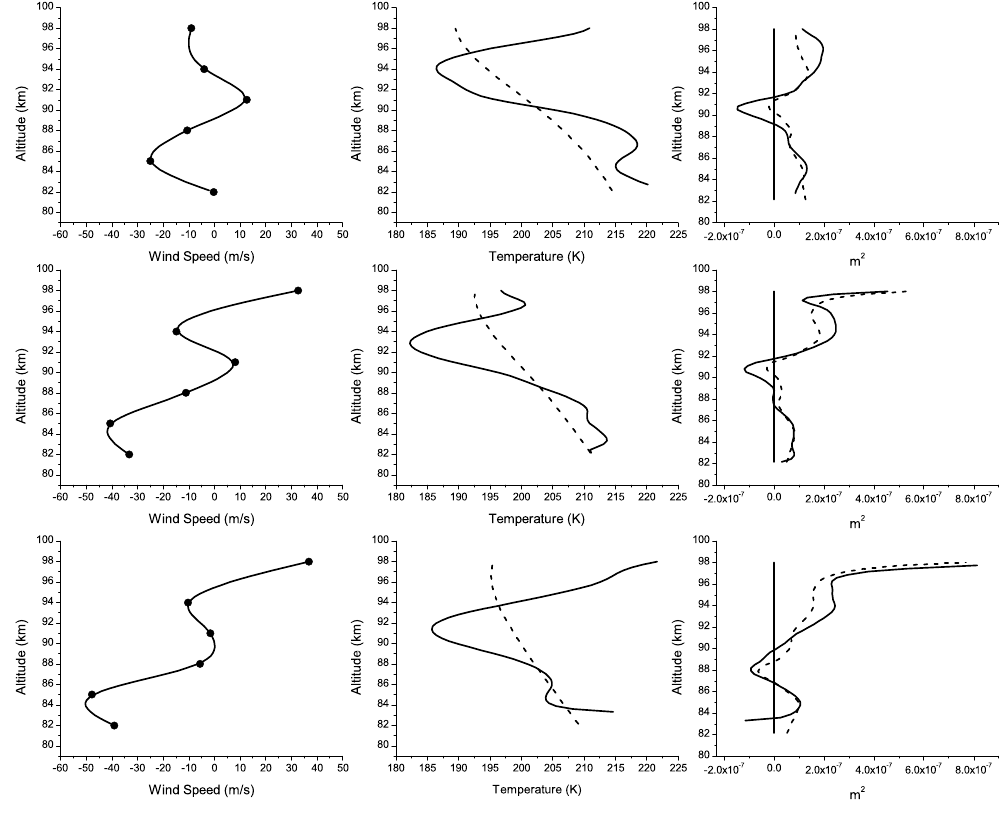
Fig. 17. Plots showing the evolution of the wind,temperature, and m 2 fields over a 3-h period (17:00, 18:00, 19:00 UT) for wave 2 observed on 27/28 January using radar and lidar data from Andenes/ALOMAR. The left column plots the radar projected wind field, the center column shows the lidar temperature field (solid line) and MSIS temperature (dashed line). The right column shows the calculated m 2 profile using lidar temperature (solid) and MSIS model data (dashed) .